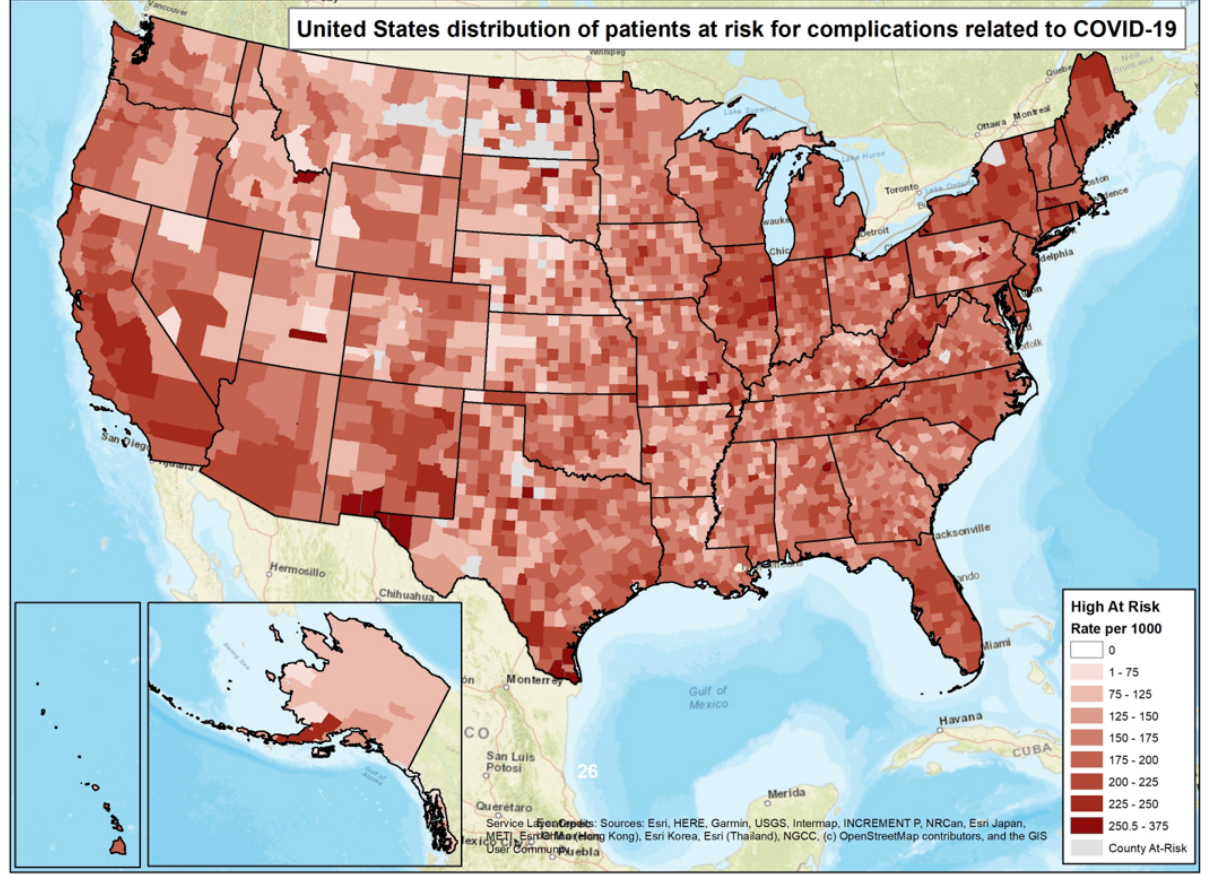
Figure 1. Distribution of patients at risk for complications related to coronavirus disease (COVID-19) in the United